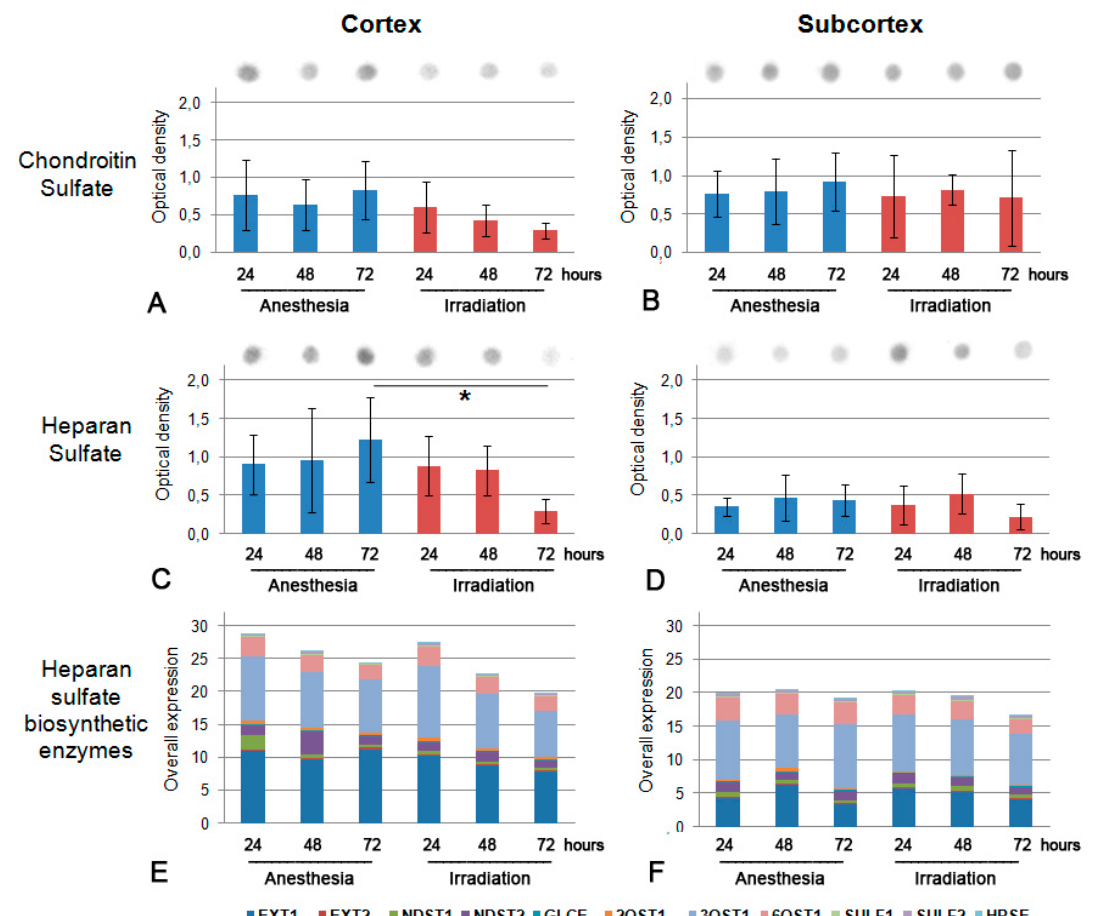
Figure 4. GAGs’ content in triple irradiated mouse brain tissue at 24, 48 and 72 h after irradiation. ( A , B ) CS content in cortex and subcortex structures (respectively). ( C , D ) HS content in cortex and subcortex structures (respectively). GAG content is normalized to total protein content, bars represent the mean ± SD from triplicate experiments (OriginPro 8.5). ANOVA, a value of p < 0.05 was considered statistically significant (* p < 0.05). ( E , F ) Overall transcriptional activity of the HS biosynthetic system in triple irradiated mouse brain tissue. The intensity of the amplified DNA fragments of HS biosynthesis-related genes was normalized to that of Gapdh . The stacked columns reflect the contribution of each gene to the total expression level based on the mean expression levels from triplicate experiments (Origin 8.5). Control—anesthetized